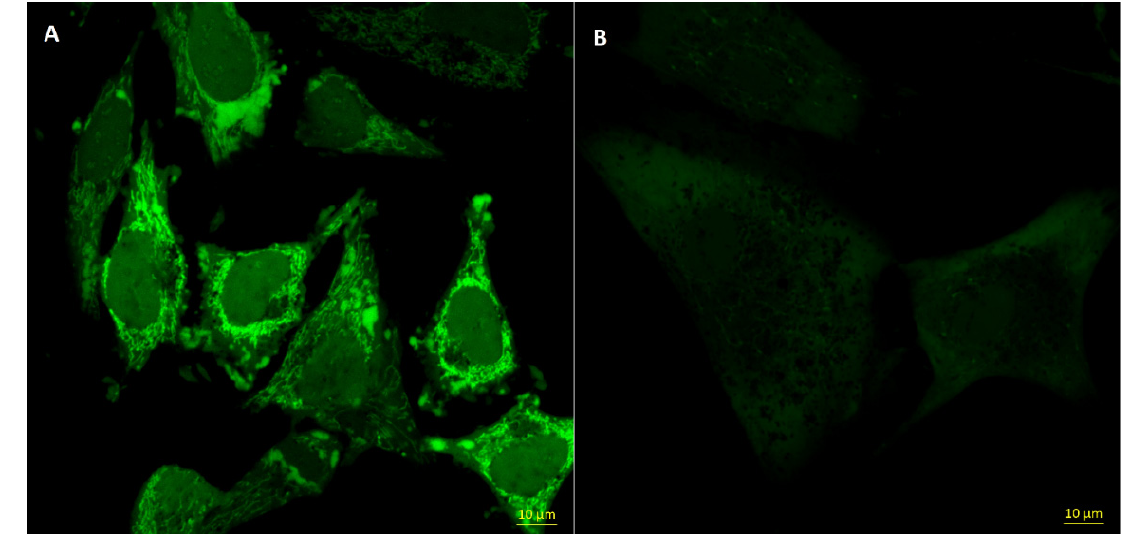
Figure 3. Confocal images showing the subcellular distribution of PLA-Jeff-FA/PLA 3000 PEG 2000 micelles with fluorescein after 24 h incubation with HeLa cells ( A ) and normal human connective tissue cells ( B ) (reproduced from Jelonek et al. [81]).